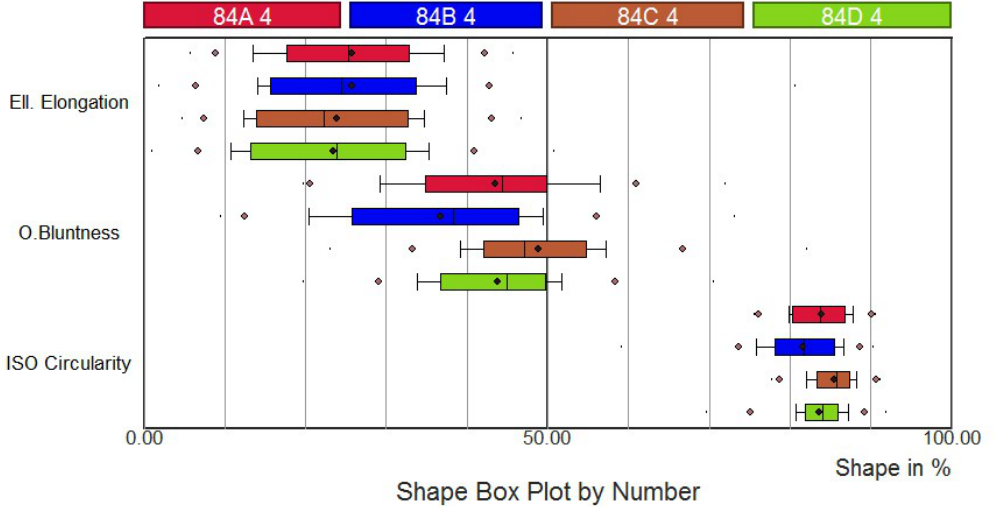
Figure A1. Shape analysis of particles (>4 mm) (84A, 84B, 84C and 84D refer to raw materials M84Af, M84Bf, M84Cf and M84Df, respectively).